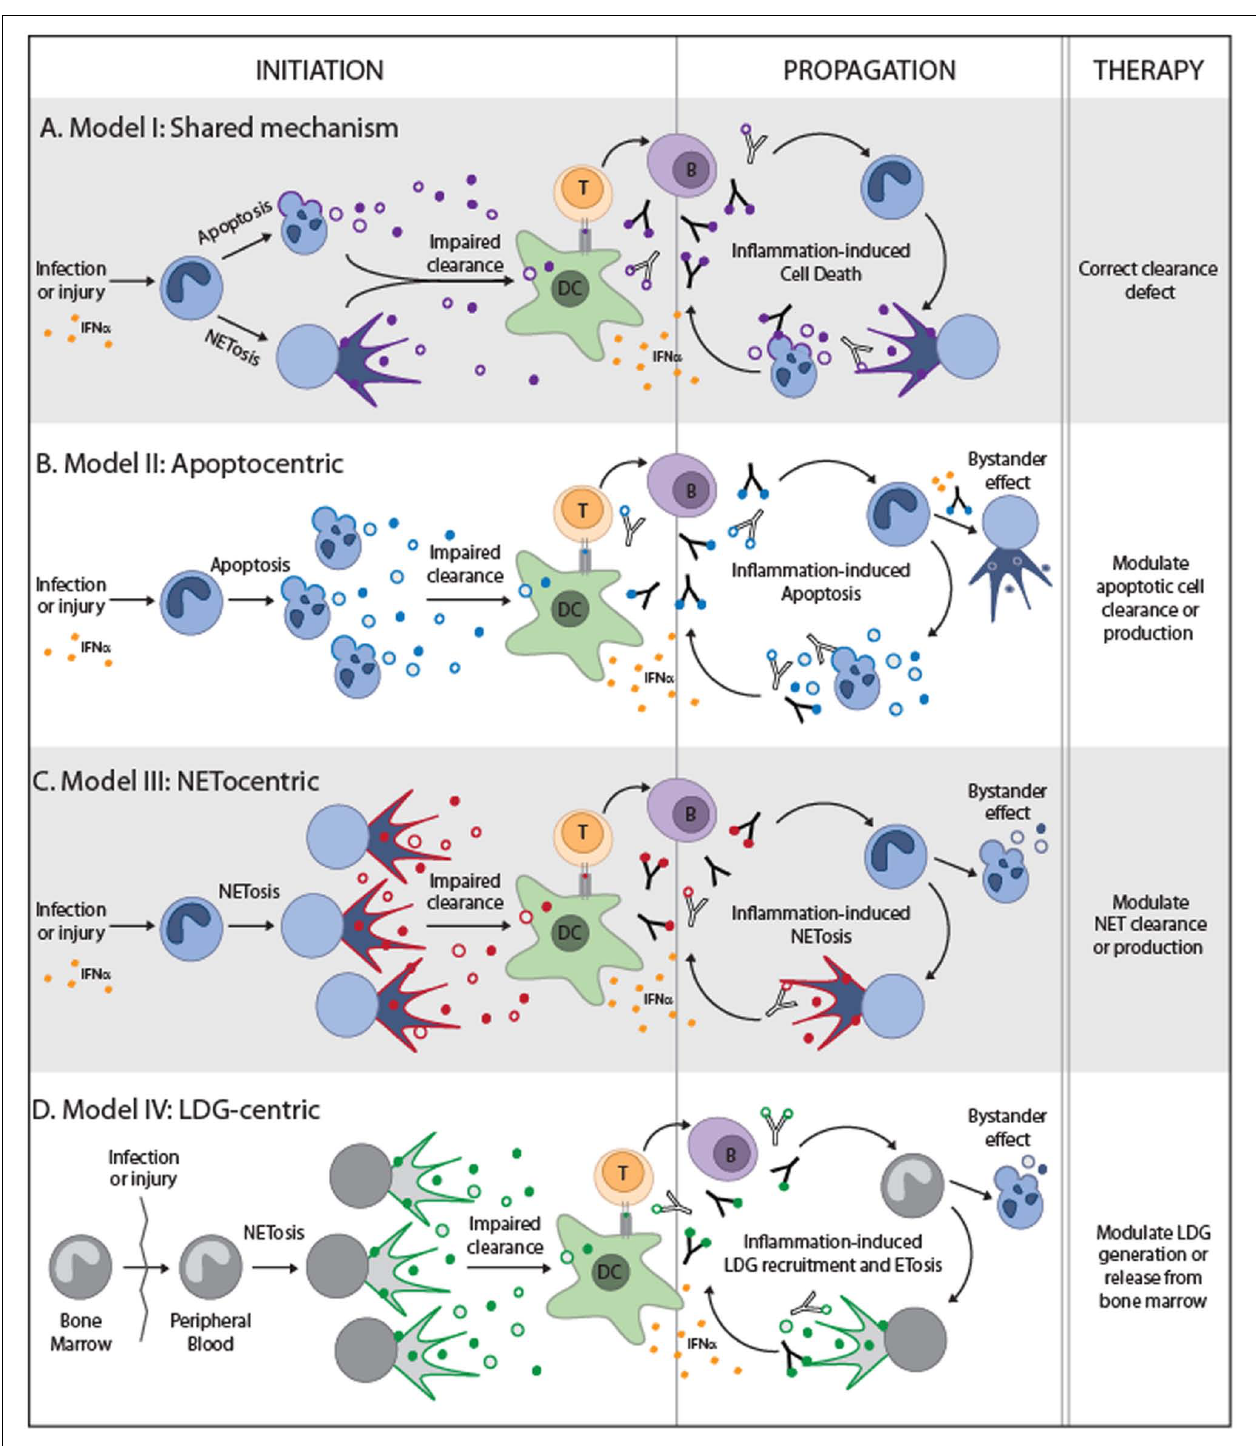
initiating sources of autoantigens in models (C) and (D) , respectively. All models require the impaired clearance of cell debris, activation of dendritic cells and production of IFN α , and presentation of autoantigens toT helper cells.T helper cells would then stimulate autoantibody production which may lead to pro-inflammatory clearance of apoptotic cells and may combine with IFN α to induce NET formation.The nuances of each model are depicted and suggested therapeutic